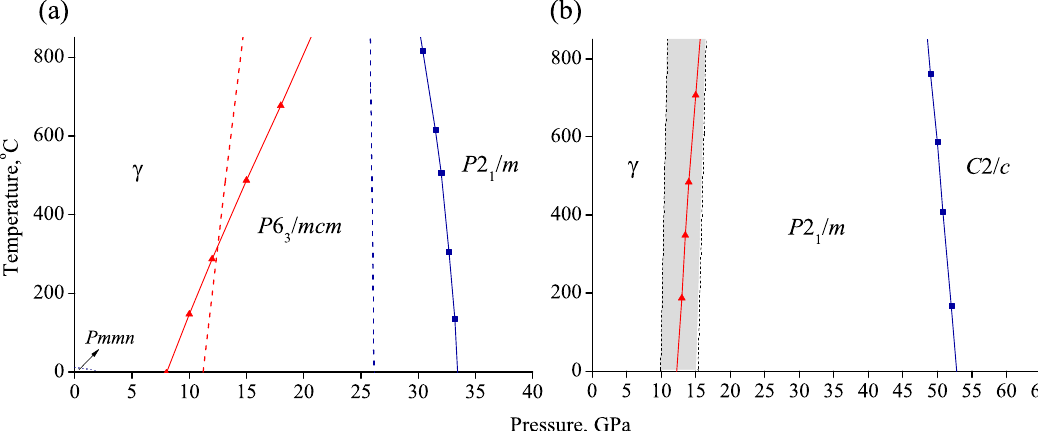
Figure 10. Theoretical P-T diagrams of Na 2 CO 3 ( a ) and K 2 CO 3 ( b ). Theoretical phase boundaries are shown in solid lines, experimental in dashed